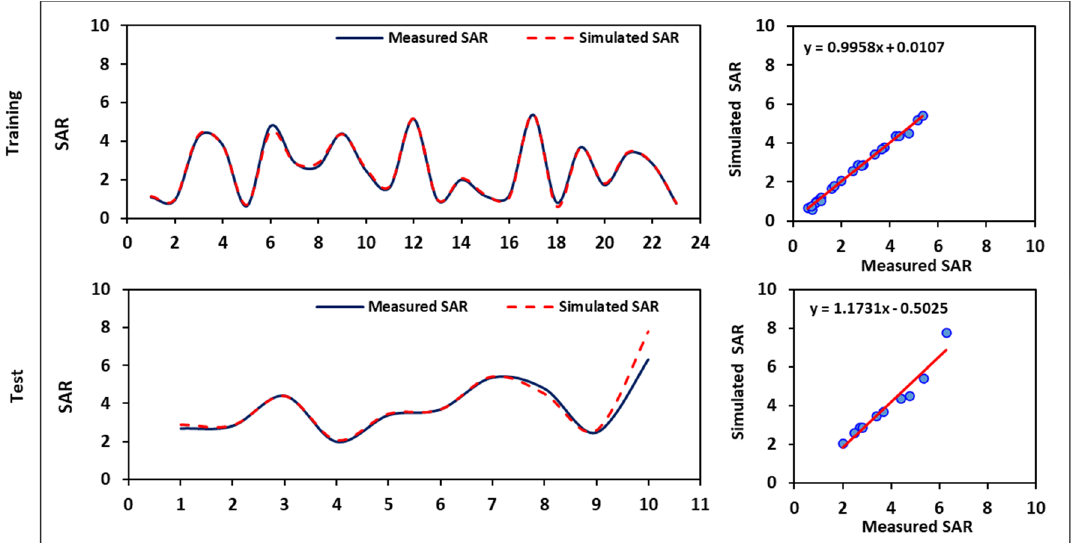
Figure 16. Results of the ANFIS model-based simulated SAR.